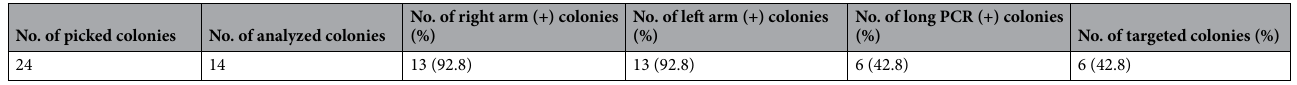
Table 2. Efficiency of GTKO/CD55/CD39 knock-in vector targeted into GGTA1